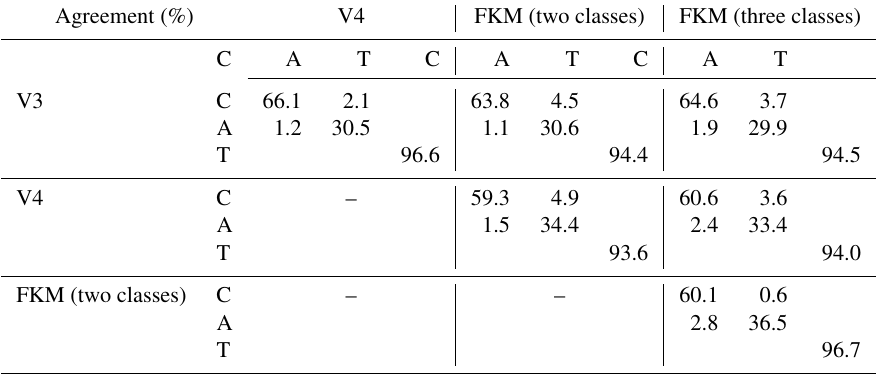
Table 2. Statistical confusion matrix of a 1-month (January 2008) CAD analysis that shows the agreement percentages (detected as clouds: C, aerosols: A, or total of clouds and aerosols: T for both algorithms) between different methods (V3: version 3, V4: version 4; FKM: fuzzy k